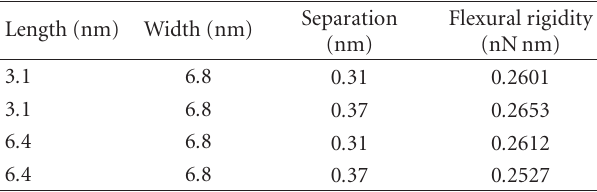
Table 2: Calculated flexural rigidities for 2D simulations. Length (nm) Width